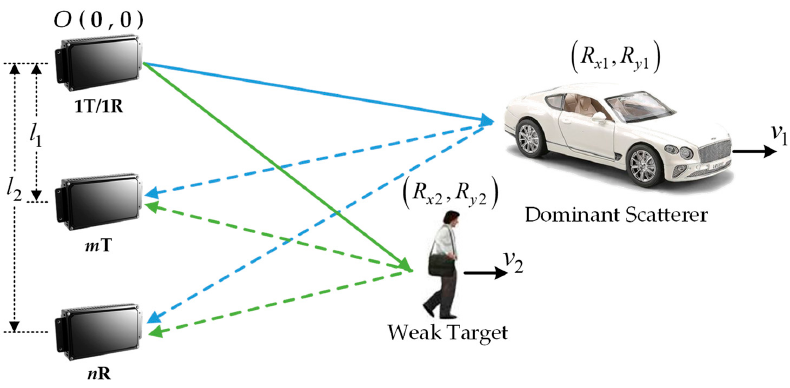
Figure 5. Geometric diagram of the DCAR and multi-target.